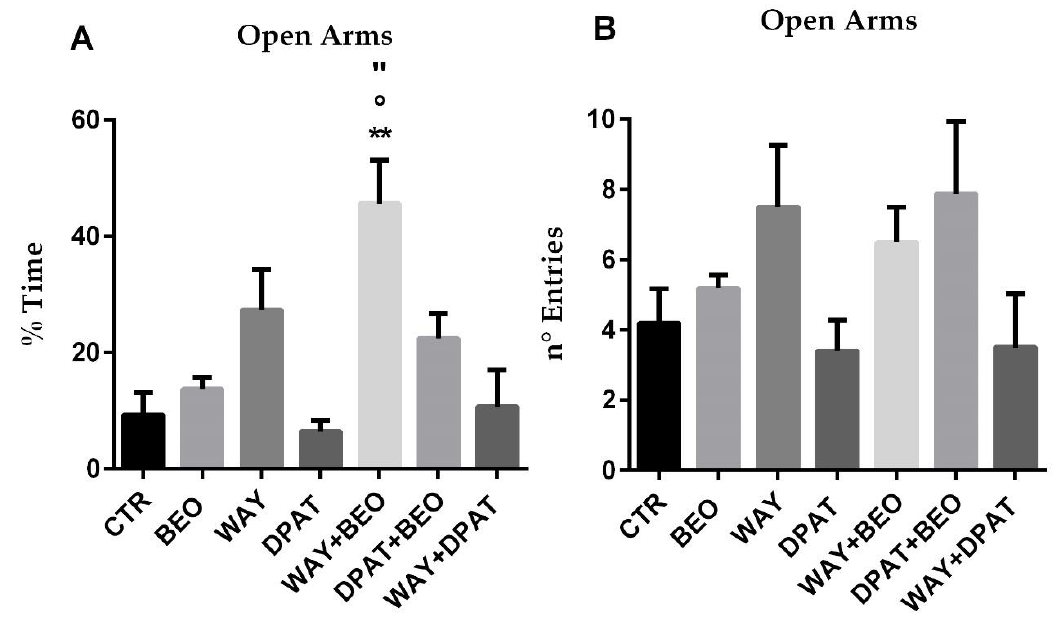
Figure 4. % of Time ( A ) and n ◦ of Entries ( B ) in open arms in the elevated plus-maze test in male Wistar rats after systemic (i.p.) administration of jojoba oil (CTR) (500 µ L / kg), Bergamot Essential Oil (BEO) (500 µ L / kg), WAY100635 (WAY) (1 mg / kg), 8-OH-DPAT (DPAT) (1 mg / kg), WAY + BEO (1 mg / kg + 500 µ L / kg), DPAT + BEO (1 mg / kg + 500 µ L / kg), and WAY + DPAT (1 mg / kg + 1 mg / kg). Data are expressed as mean ± SEM ( n = 5–8 per group). ** p < 0.01 vs. control group; ◦ p < 0.05 vs. BEO group; “ p < 0.05 vs. WAY group. Statistical analysis was performed by one-way ANOVA followed by individual comparisons with Tukey Multiple Comparison’s test.